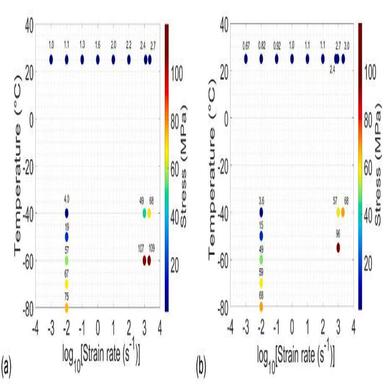
Strain rate and temperature dependence on the peak stress for the 50% filled composites: (a) F-NR4 and (b) F-NR5.